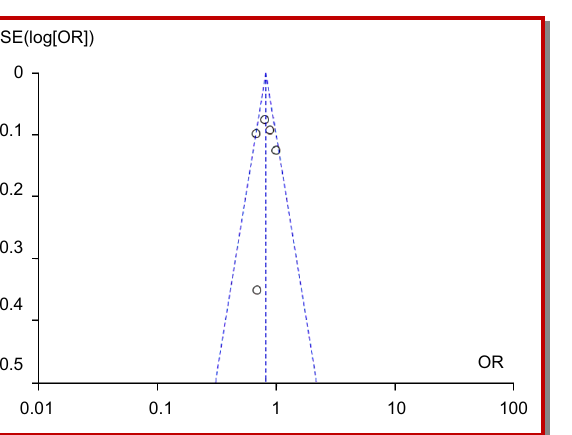
Figure 4: Forest plot of risk of bleeding event between NOACs and vitamin K antagonists